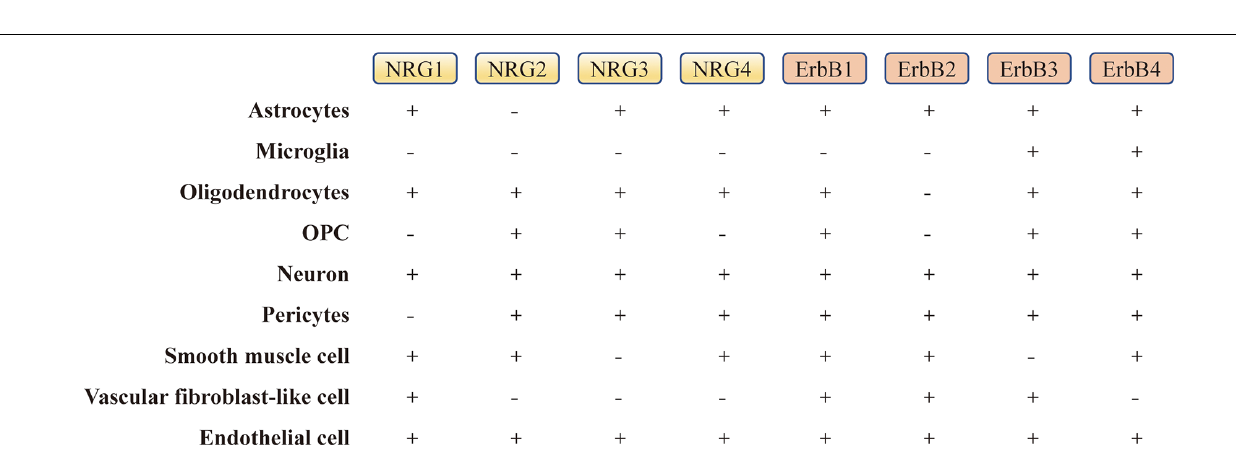
N-terminal domain of NRG3 is similar to SMDF (Ho et al.,